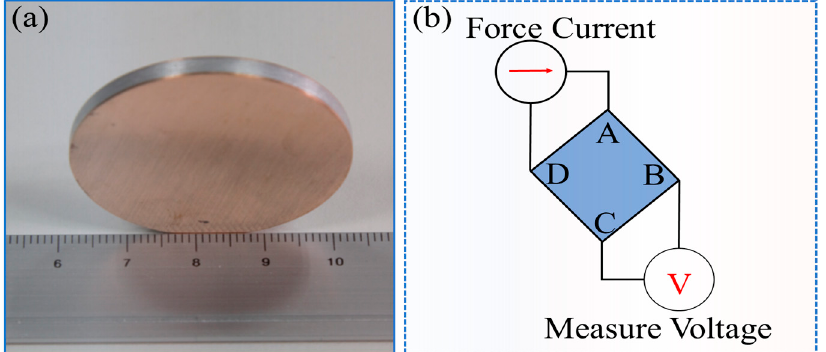
Figure 2. Schematic diagram of the sample for testing electrical conductivity. ( a ) Macroscopic photograph of the sample; ( b ) Schematic diagram of the van der Pauw method for measuring resistance.